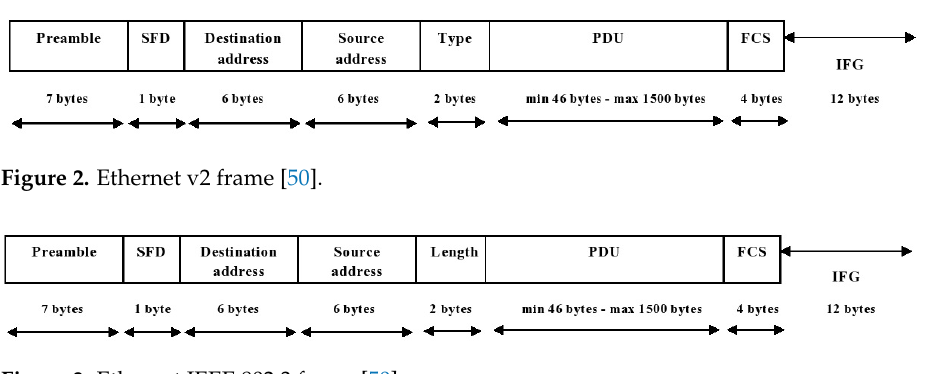
Figure 3. Ethernet IEEE 802.3 frame